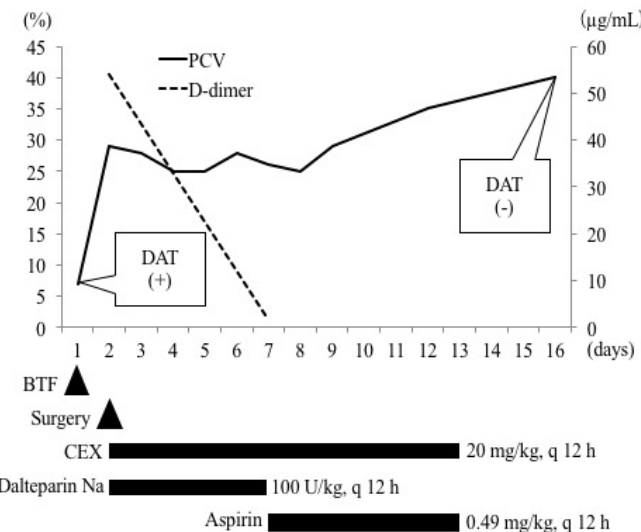
Figure 3. Results of changes in packed cell volume (PCV), Coombs test, D-dimer concentration, and administered drugs. DAT = direct antiglobulin test; BTF = blood transfusion; CEX = cephalexin.